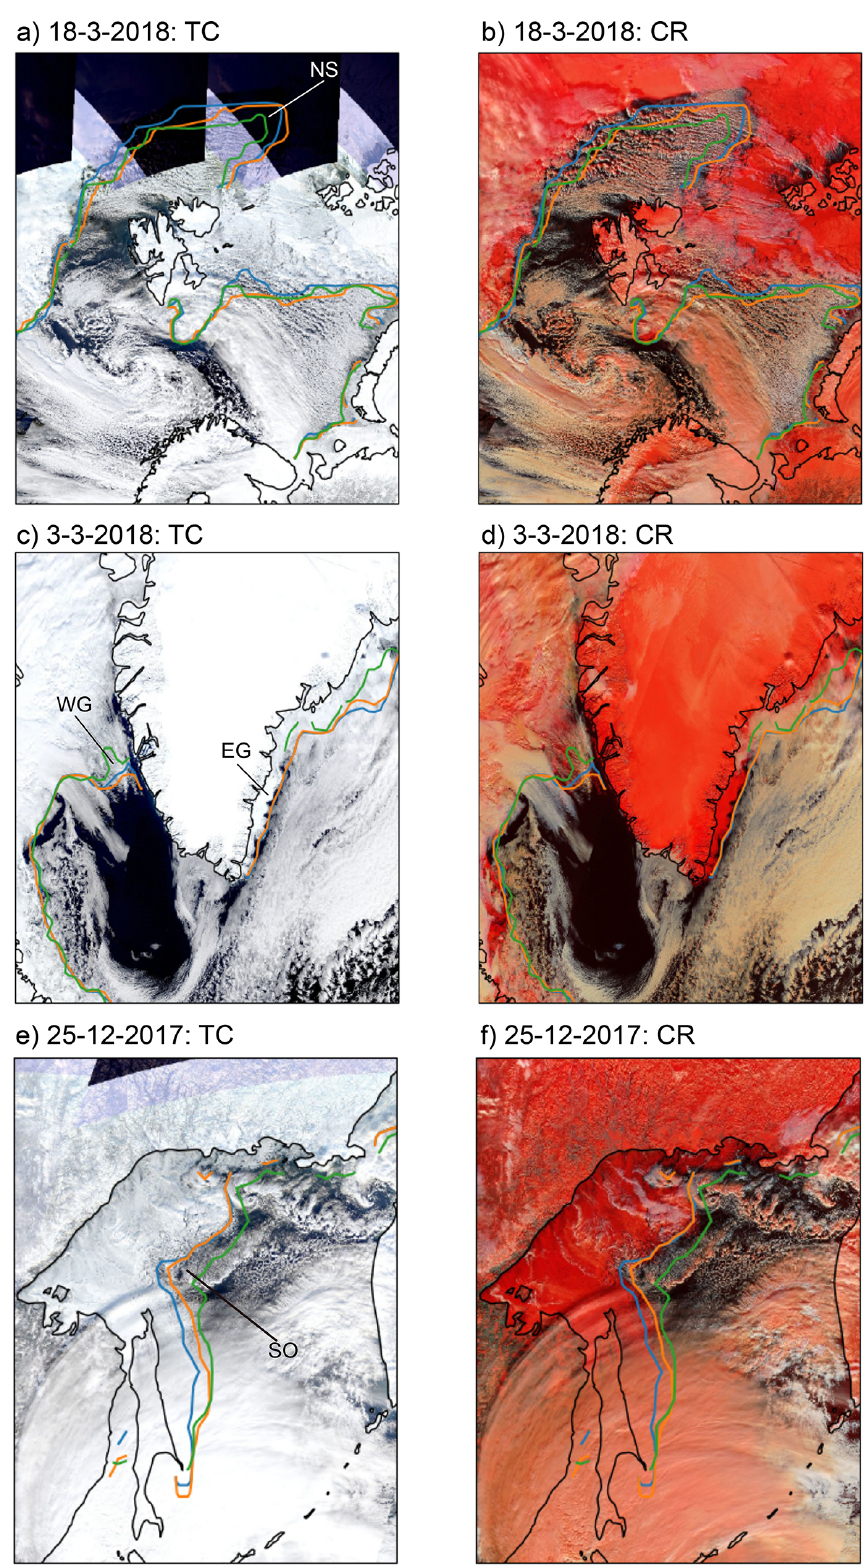
Figure 4. MODIS True Color (a, c, e) and Corrected Reflectance (b, d, f) images for the Nordic Seas on 18 March 2018 (a, b) , Labrador and North-East Atlantic region on 3 March 2018 (c, d) , and Sea of Okhotsk on 22 December 2017 (e, f) . The 0.2 ice fraction contours from OSI SAF (blue), OSI SAF 1d (orange) and ECMWF OCEAN5 (green) are overlaid. These regions are shown by the coloured boxes in Fig. 1c and f. Areas of large discrepancy between the OCEAN5 analysis and MODIS images are annotated. https://doi.org/10.5194/wcd-3-713-2022 Weather Clim. Dynam., 3, 713–731,